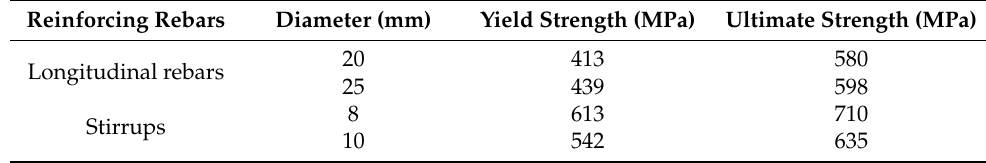
Table 3. Reinforcing rebar material